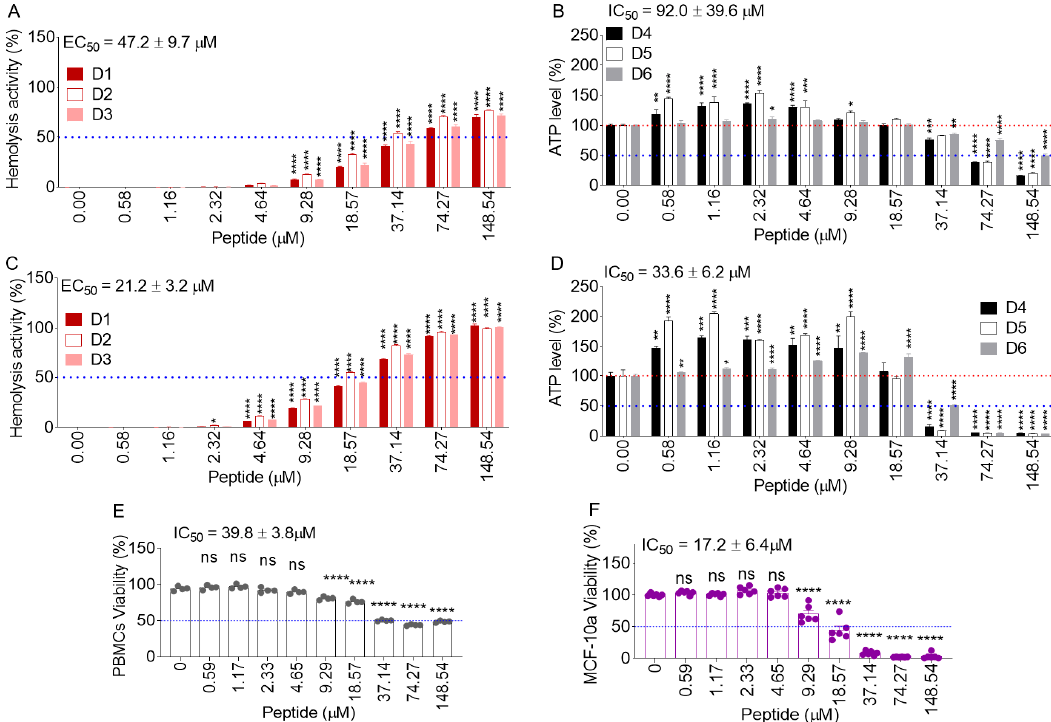
Figure 3. Response of erythrocytes and peripheral blood mononuclear cells (PBMCs) to B18L: Hemolytic and cytotoxic effects of B18L respectively on erythrocytes and PBMCs at 0.75 h ( A and B ) and 24 h ( C and D ) post treatment. Cytotoxic effects of B18L on PBMCs was assessed using the ATP assay. ( E ) MTT viability assay of PBMCs after treatment with B18L for 24 h. ( F ) MTT viability assay of MCF-10a cells after treatment with B18L for 24 h. Each erythrocyte and PBMC assay used three independent healthy donors ( D ) D1 to D3 were used for hemolysis while D4 to D6 were used for PBMC viability. Error bars represent the standard error of the mean (SEM) of at least four replicates. Ordinary one-way ANOVA test (Dunnett’s correction) was used to determine the di ff erences between the treated groups as compared to vehicle treatment. * p < 0.05, ** p < 0.01, *** p < 0.005, **** p < 0.001; not significant was not shown for clarity for panels A-D and shown as ns for panels E-F. Experiment was repeated at least three times, with similar